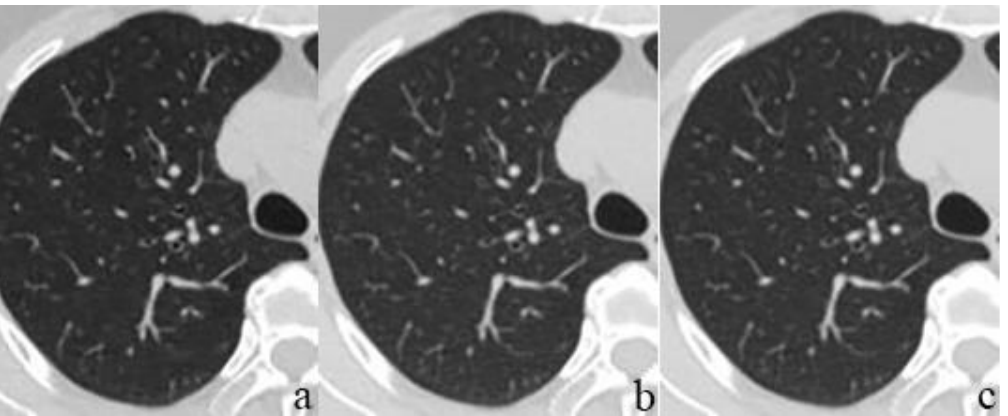
Figure 2. Soft tissue images of a 62-year-old female after chest LDCT. Three reconstruction methods were used: ASIR-V 50% ( a ), DLIR-M ( b ), and DLIR-H ( c ). The image signal did not significantly vary across different reconstructions (all p > 0.05). Image noise significantly varied across different reconstructions (all p < 0.05). Both radiologists agreed that DLIR-H had the best image quality, with low noise and a natural texture.